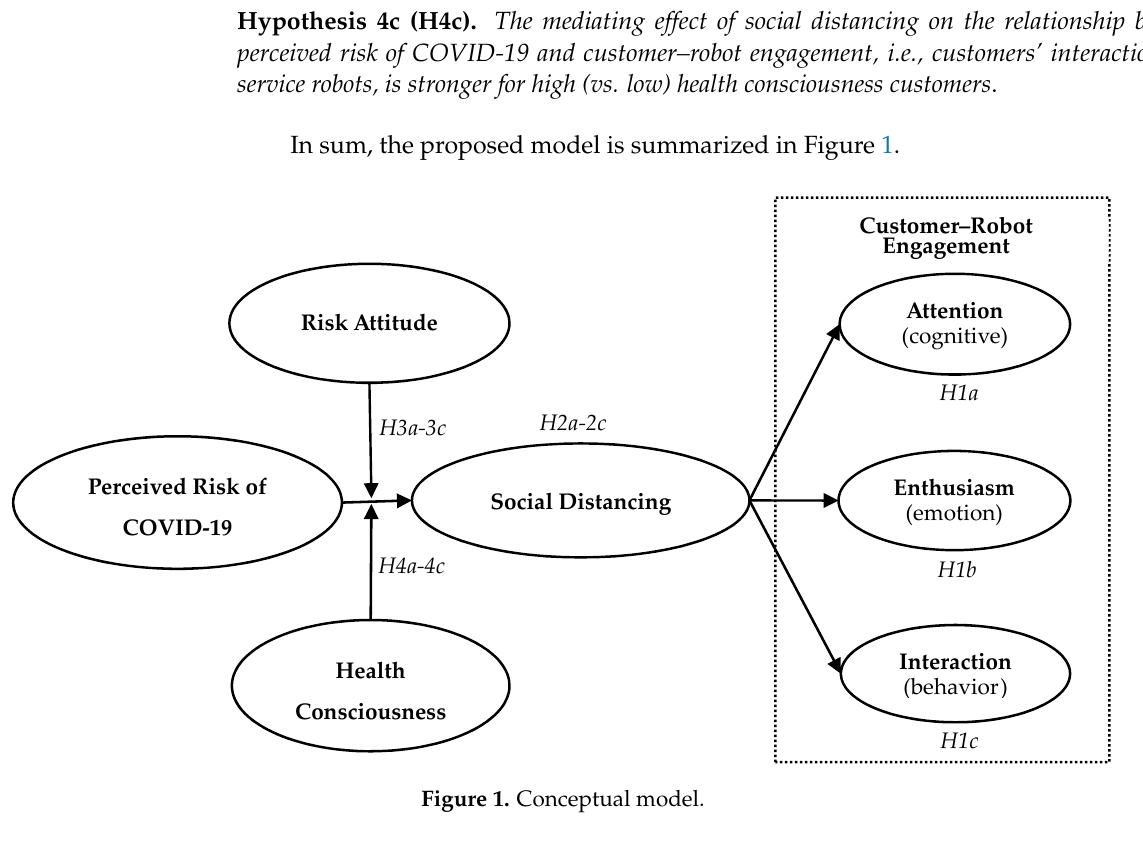
Figure 1. Conceptual model.